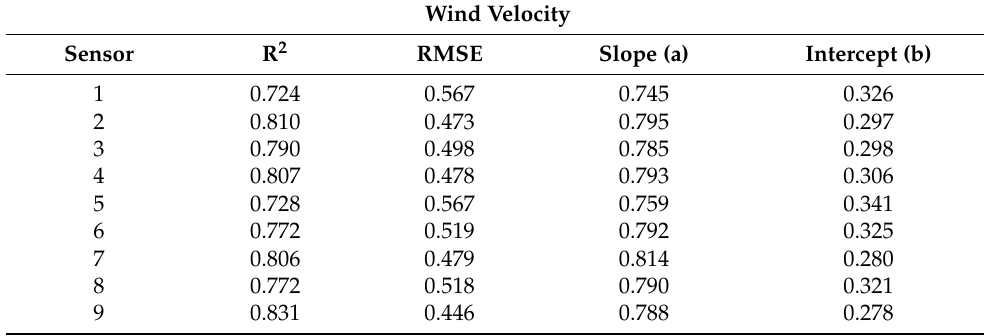
Figure 6. Same as Figure 3 but for wind velocity. Table 4. Statistical results of the inter-comparison of the Wind Velocity of the GMX500